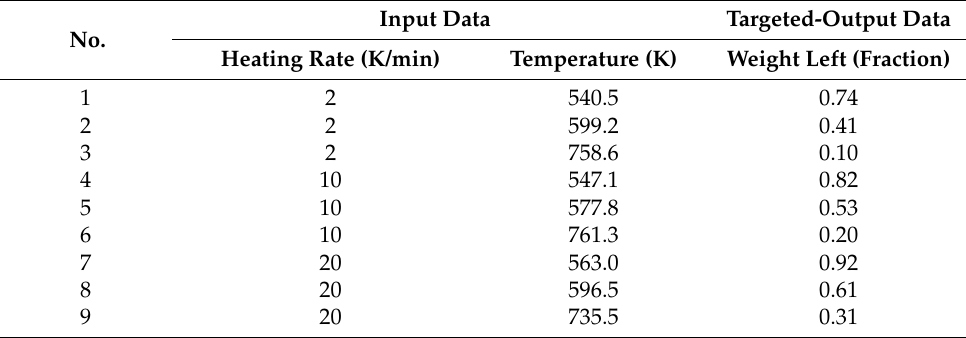
Table 12. Input and targeted-output data used during the simulation step.